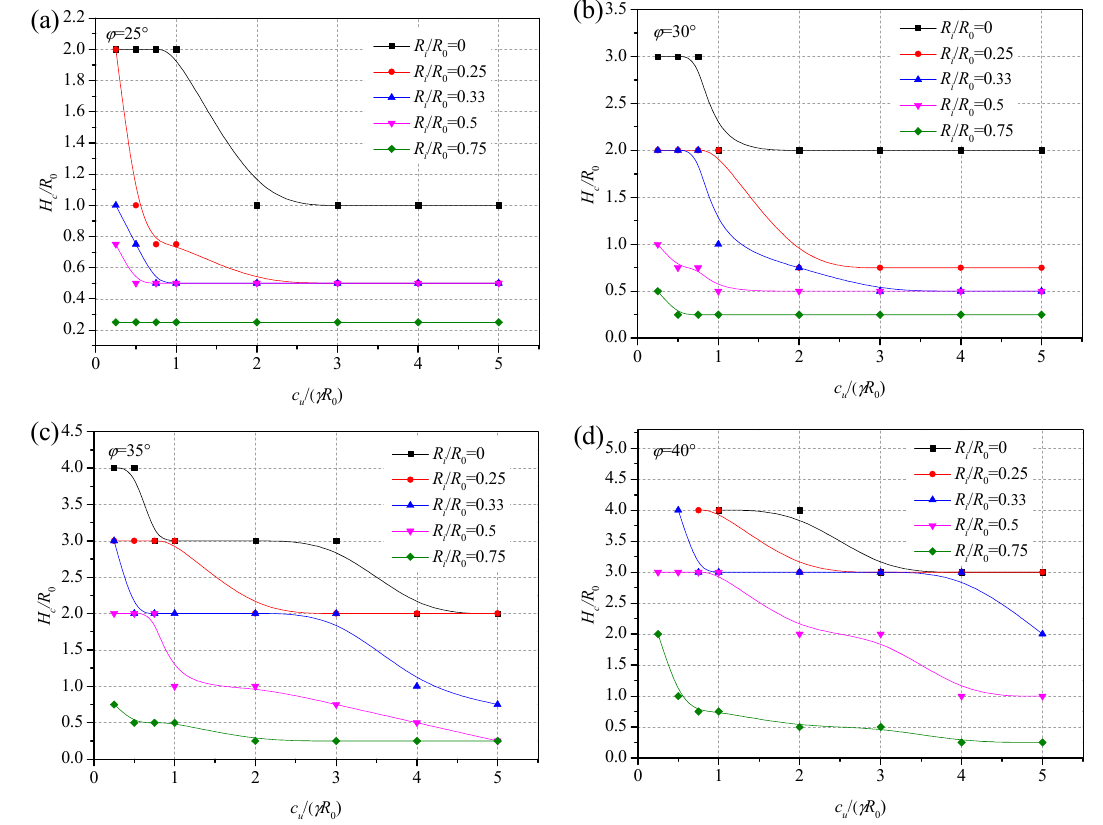
Figure 7. Variation in the critical thickness, H / R 0 , with c u /( γ R 0 ) and R i / R 0 for (a) φ =25°, (b) φ =30°, (c) φ =35°, and (d) φ =40°.